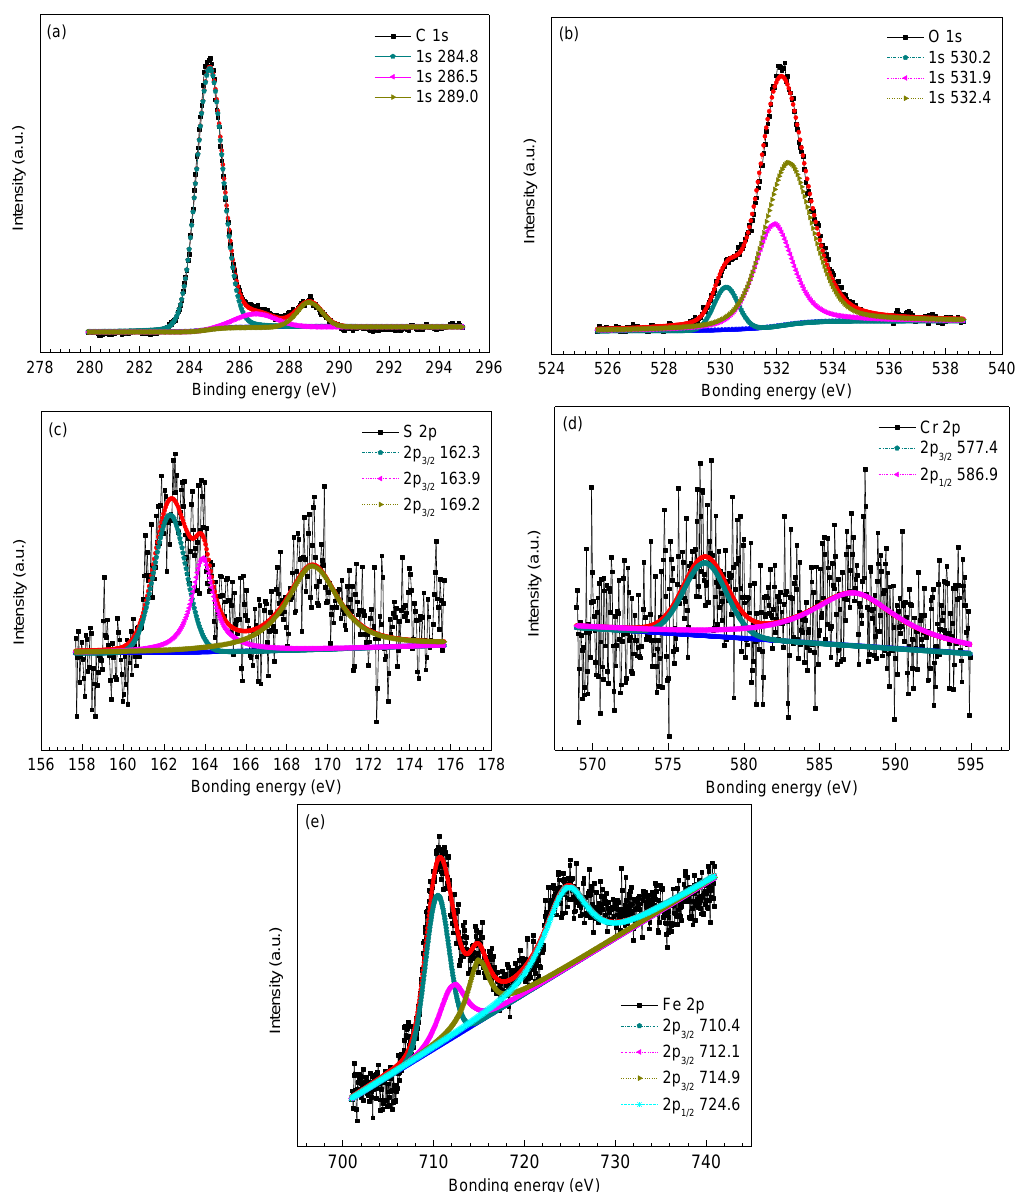
Figure 5. X-ray photoelectron spectroscopy (XPS) spectra and decomposition of peaks for different elements of the inner scale on P110 steel: ( a ) C 1s; ( b ) O 1s; ( c ) S 2p, and ( d ) Fe 2p.